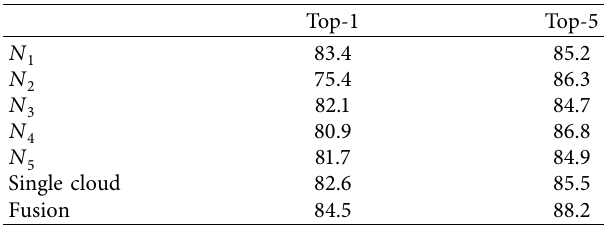
Table 3: Edge node and cloud fusion recognition results (accuracy rate).